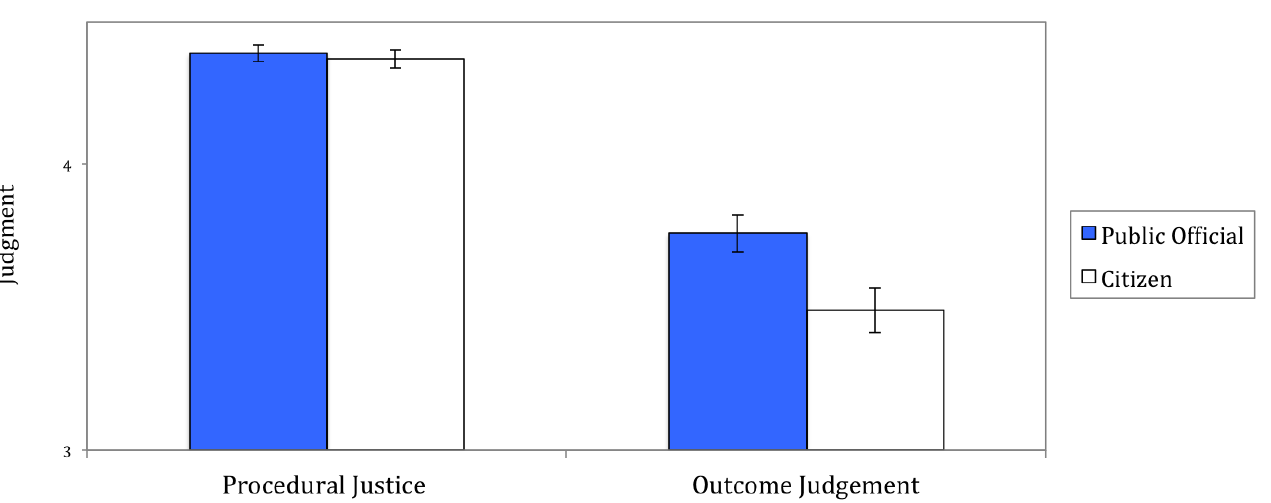
Figure 8 . Citizens’ and public officials’ perceptions of procedural justice and judgments of whether cases were resolved or not. Scores are on 5-point scales with higher values indicating higher levels of perceived procedural justice or more positive judgments that a case or problem was resolved. Error bars represent standard errors of the